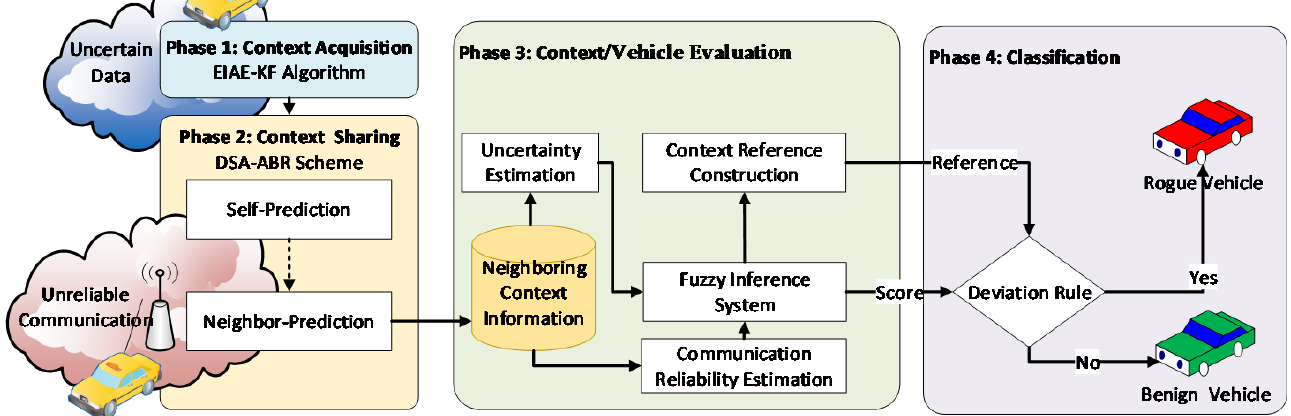
Figure 1. The proposed fuzzy-based context-aware approach for detecting rogue nodes.